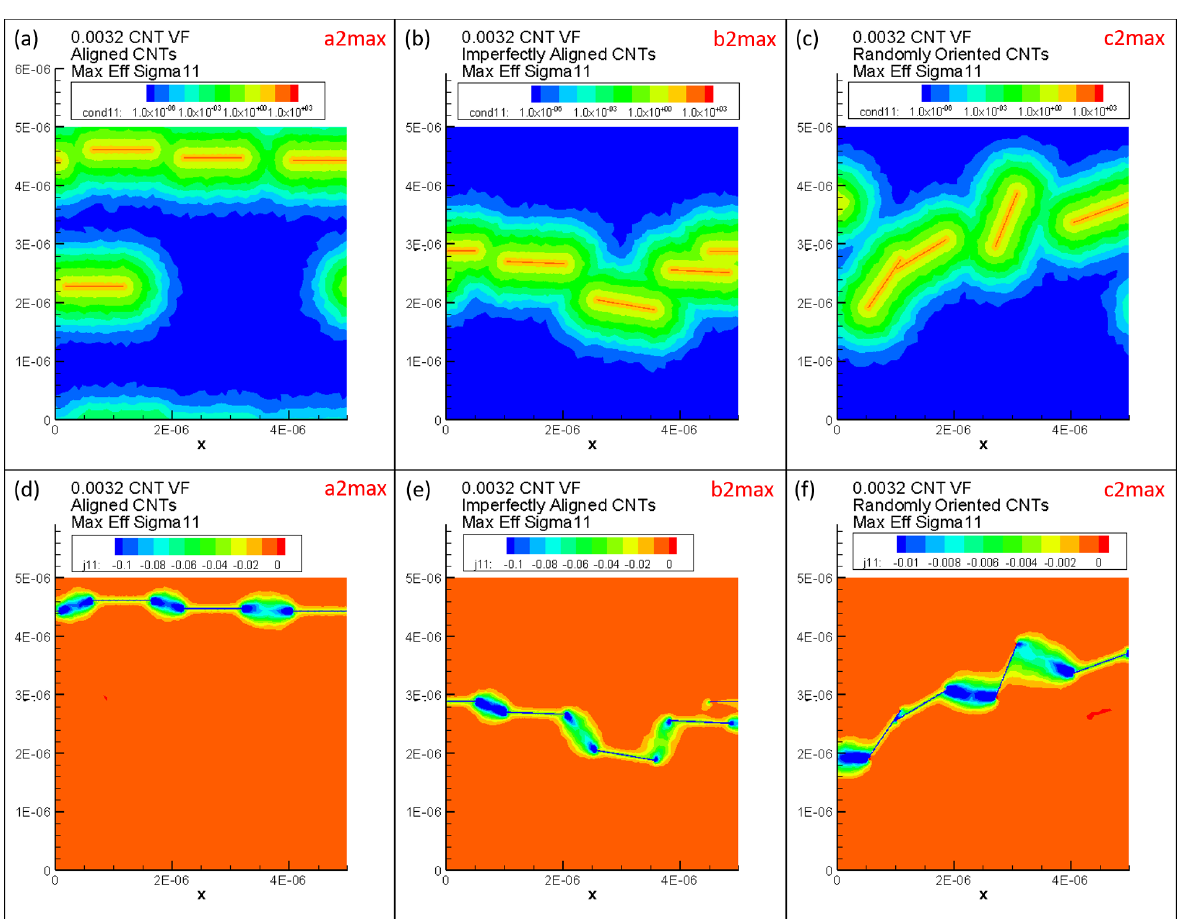
Figure 19. Local conductivity Σ 11 S/m for the maximum Σ Ef f realizations at 0.32% CNT volume 11 fraction for ( a ) ˜ x 1 aligned, ( b ) ˜ x 1 imperfectly aligned and ( c ) randomly oriented cases with local current density J 1 A / m 2 for the maximum Σ Ef f realizations at 0.32% CNT volume fraction for ( d ) ˜ x 1 11 aligned, ( e ) ˜ x 1 imperfectly aligned and ( f ) randomly oriented